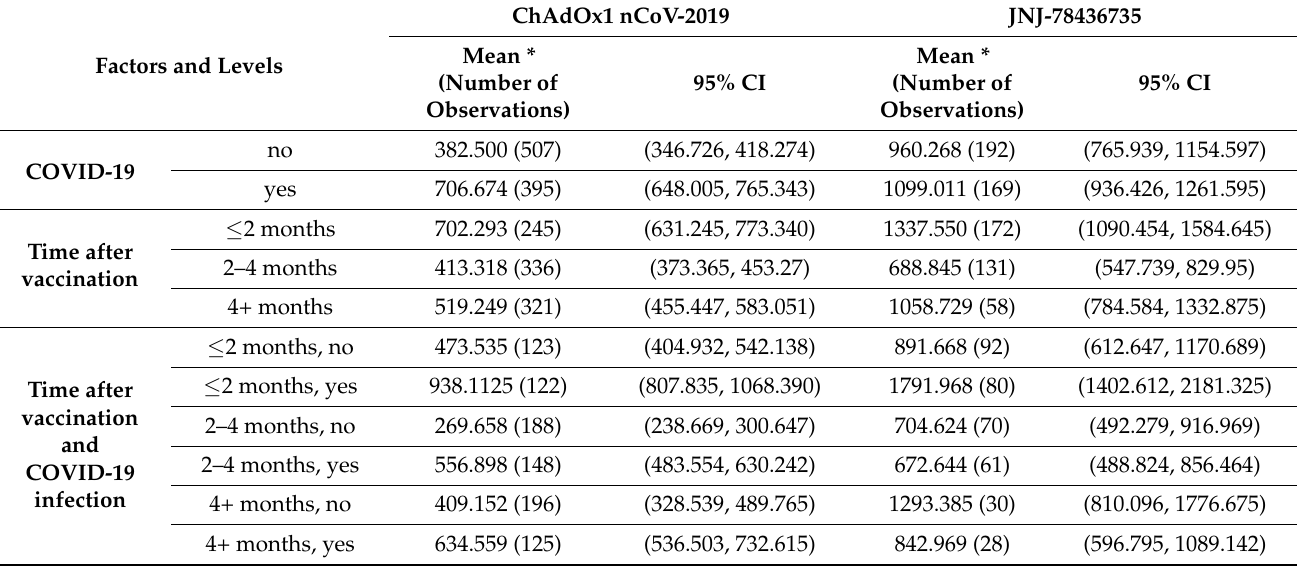
Table 9. Estimated marginal means, the 95% confidence intervals, and the numbers of observations for each group determined by levels of COVID-19 prior infection, the time after vaccination, and the interaction for ChAdOx1 nCoV-2019 and